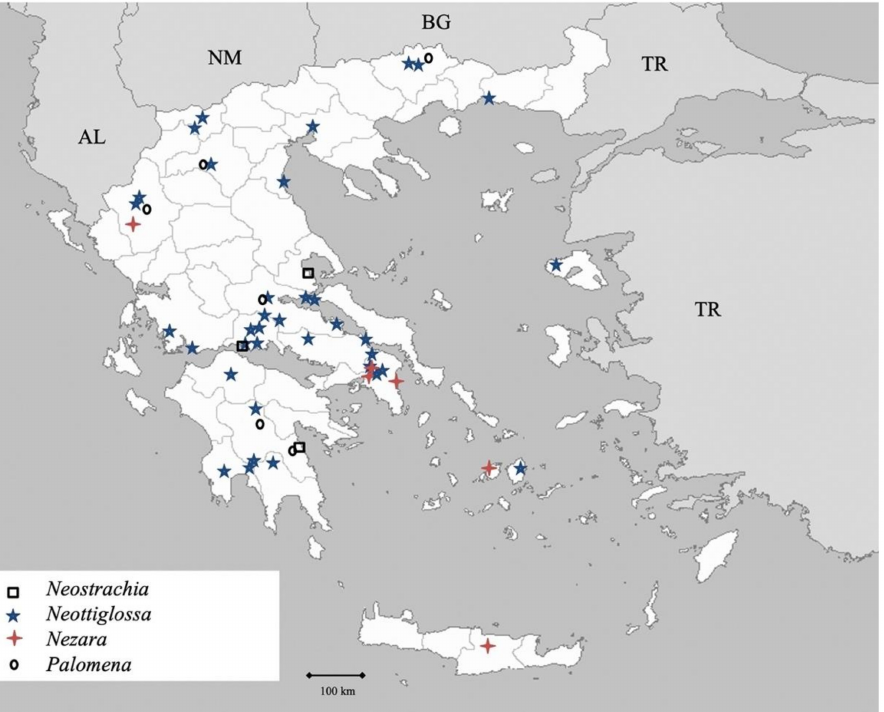
Figure 13. Map showing collecting sites of species of genera Neostrachia, Neottiglossa, Nezara and Palomena during the present study in Greece.